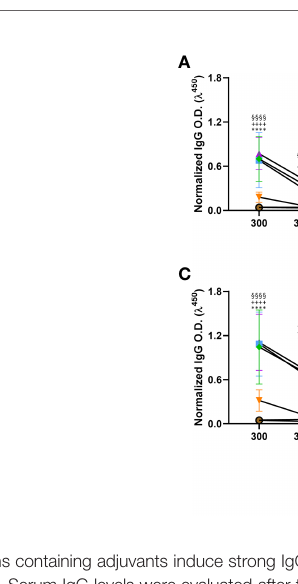
vaccinated with S Ptn + Poly(I:C) in comparison to S Ptn.